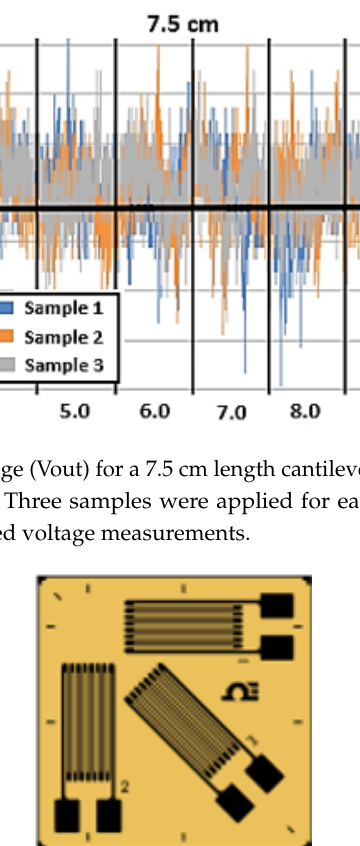
Figure 29. Rectangular rosette 0 ◦ /45 ◦ /90 ◦ strain-gauge array; model: SGD-6/350-RYT21; 350 Ω of nominal resistance, 16.3 mm per side with a gauge factor of